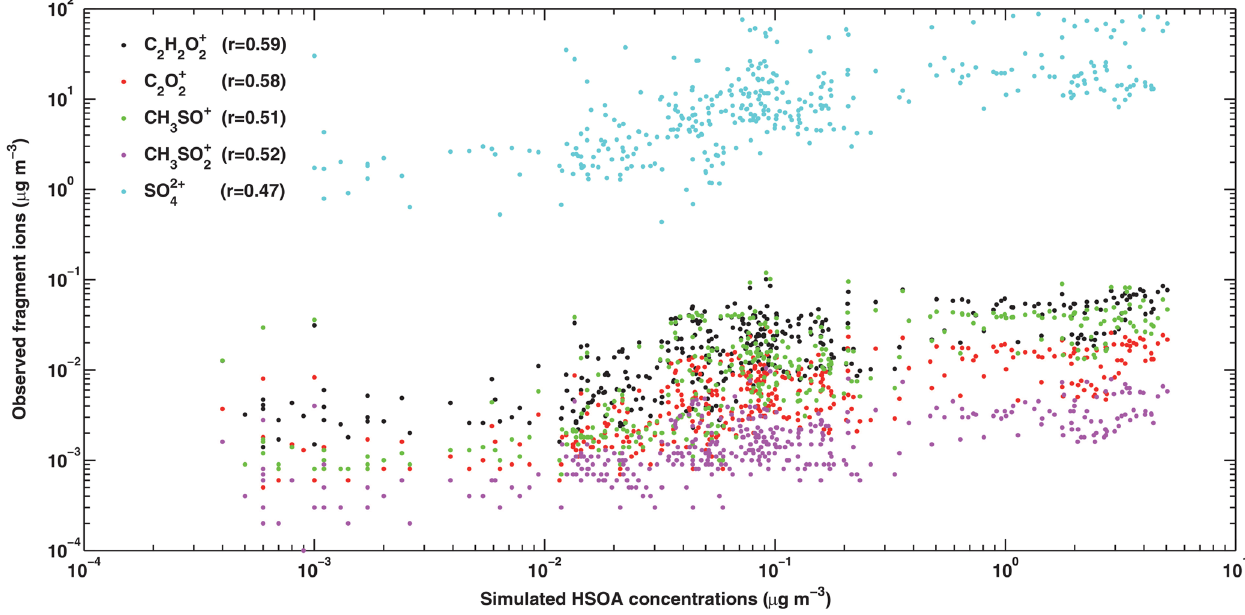
Figure 10. Scatterplot of the simulated HSOA concentration and the AMS measured SO 2 + concentrations from 9 to 26 January 2014 at the IRSDE site in Beijing. All of the correlations are statistically significant with p values smaller than 0.01.